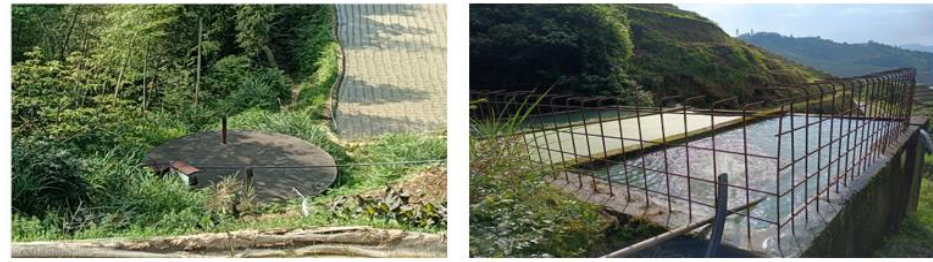
Figure 3. One of the Cistern and Sewage Treatment Centres in Ping ’ an (Source: by author